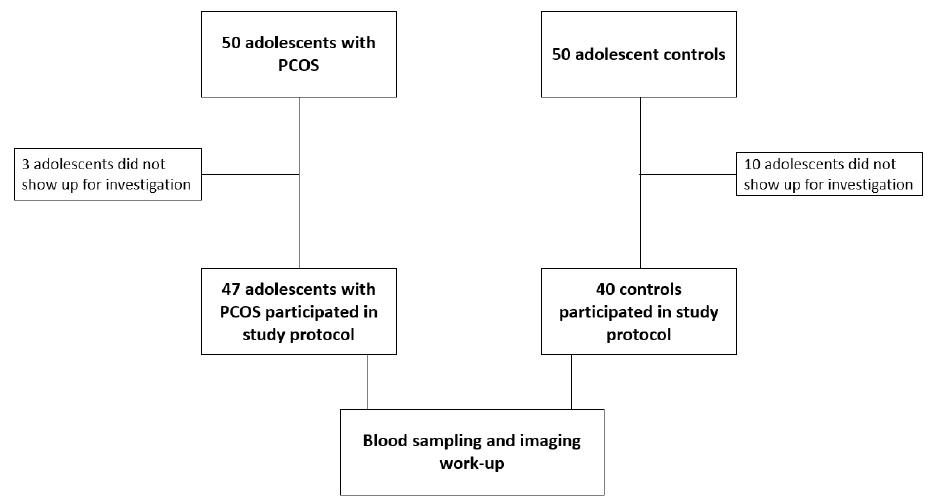
Figure 1. Flow chart of study participants.